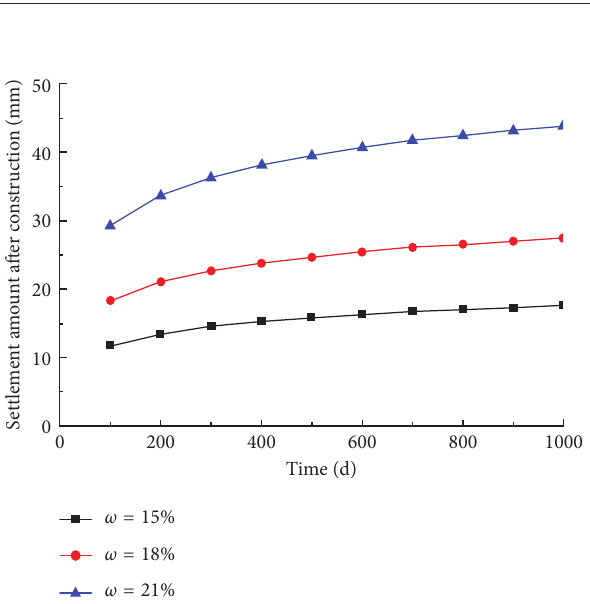
Figure 13: The calculation results of creep deformation under different moisture content conditions.